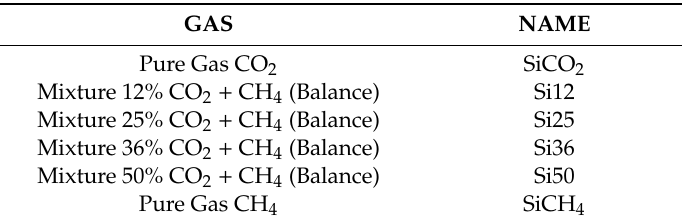
Table 1. Names of the adsorption isotherms.